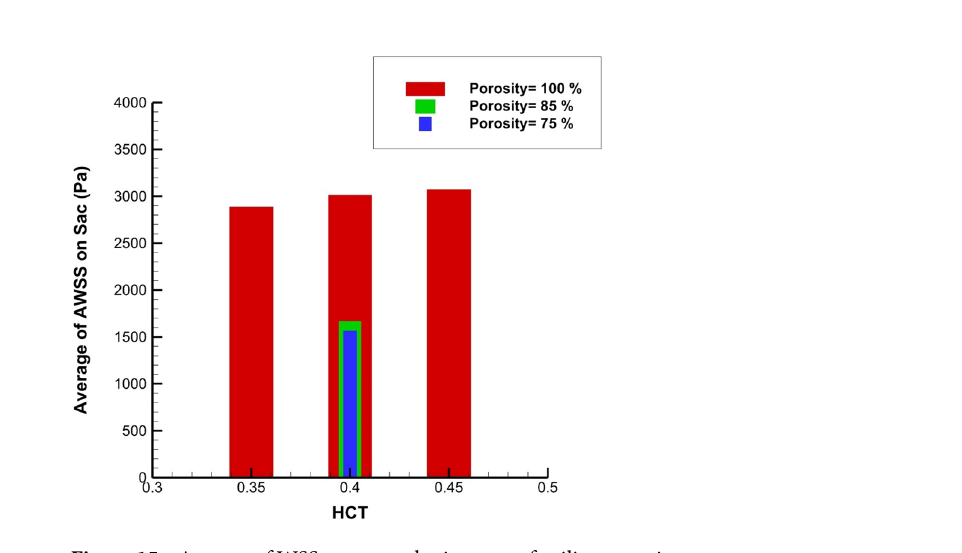
Figure 15. Average of WSS on sac under impacts of coiling